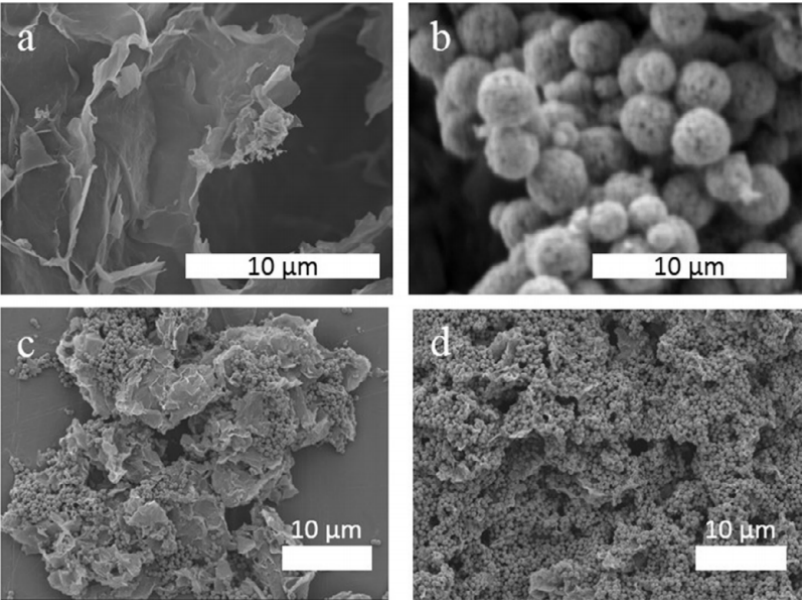
Figure 19. SEM images of ( a ) blank graphene, ( b ) iron oxide, ( c ) NH2-functionalized decorated gra- phene, and ( d ) SO3H-functionalized decorated graphene. Reprinted with permission from ref. [54]. Copyright 2017 Elsevier.